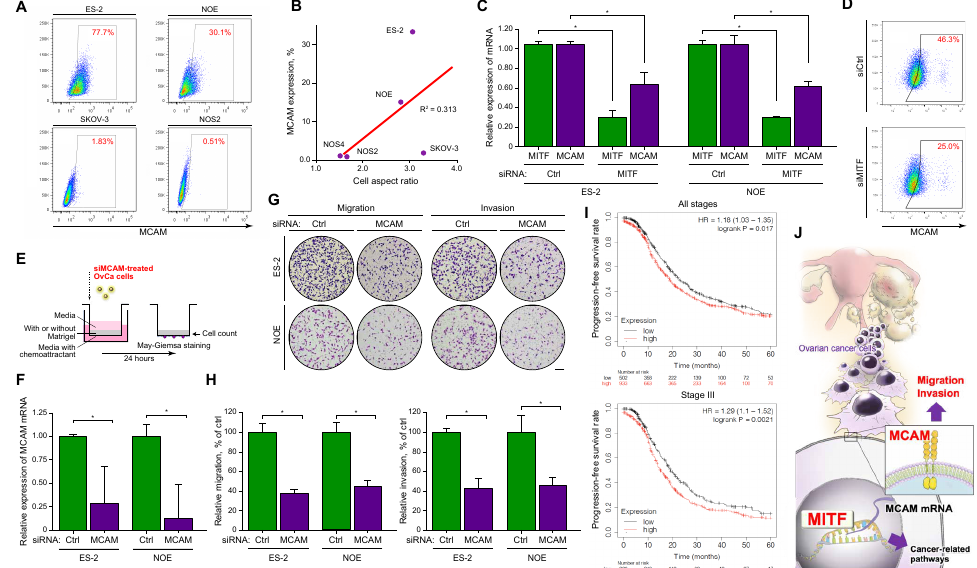
Figure 5. MCAM modulated by MITF promotes motility and invasion of OvCa cells. ( A ) Flow cytometry images demonstrating MCAM on OvCa cells. ( B ) Correlation between MCAM expression on flow cytometry and cell aspect ratios of OvCa cell lines. ( C ) Relative expression of MITF and MCAM mRNA in ES-2 and NOE cells treated with control or MITF-targeted siRNA. * p < 0.05 ( t -test). ( D ) Flow cytometry images of MCAM on ES-2 cells treated with control or MITF-targeted siRNA. ( E ) Schematic protocol for the motility and invasion assay. ( F ) Relative expression of MCAM mRNA treated with control or MCAM-targeted siRNA. ( G ) Representative images from the motility and invasion assays. Scale bar: 200 µ m. ( H ) Relative migration and invasion percentages of ES-2 and NOE cells under siRNA treatment. * p < 0.05 ( t -test). ( I ) Kaplan–Meier curves of all patients and those with stage III OvCa, stratified by di ff erences in MCAM expression. ( J ) Graphical abstract of the findings in this